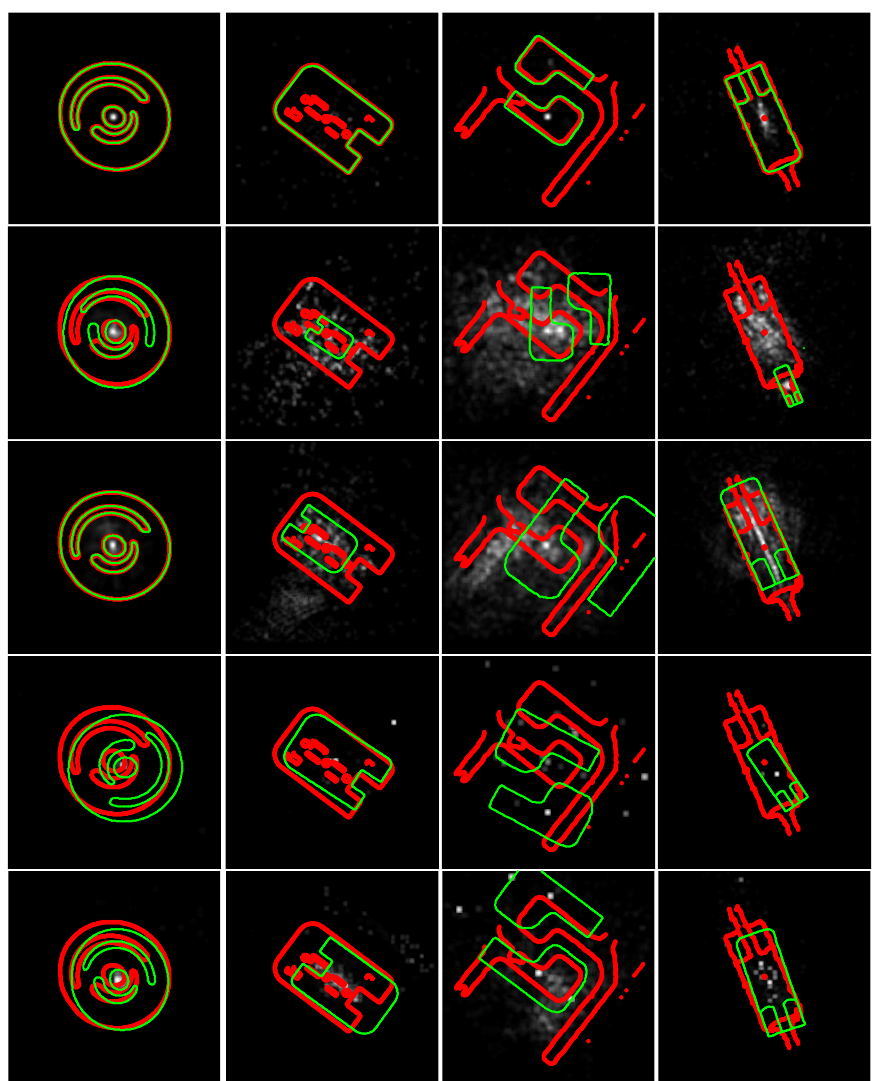
Figure 11. Examples of positioning results for some typical shapes (columns) for the proposed RV-GHT, the GDP-GHT, the PI-GHT, the GFGHT, and the FRGHT (in top-down order). The red and green contour are the source image contour and detection results, respectively. The white clouds are the centre voting